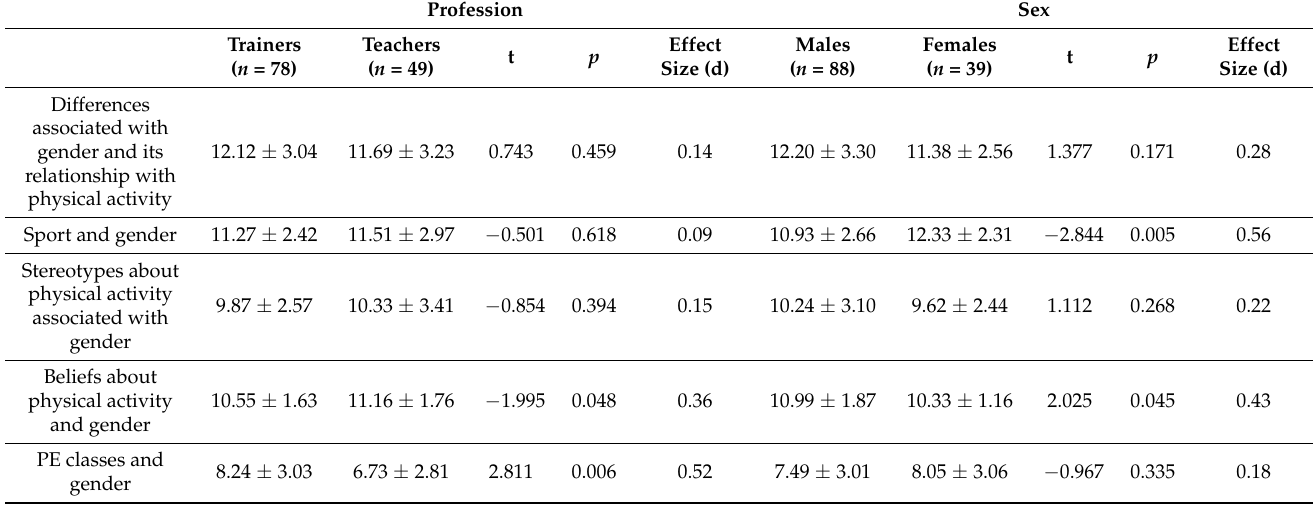
Table 1. Gender stereotypes present in trainers and teachers.